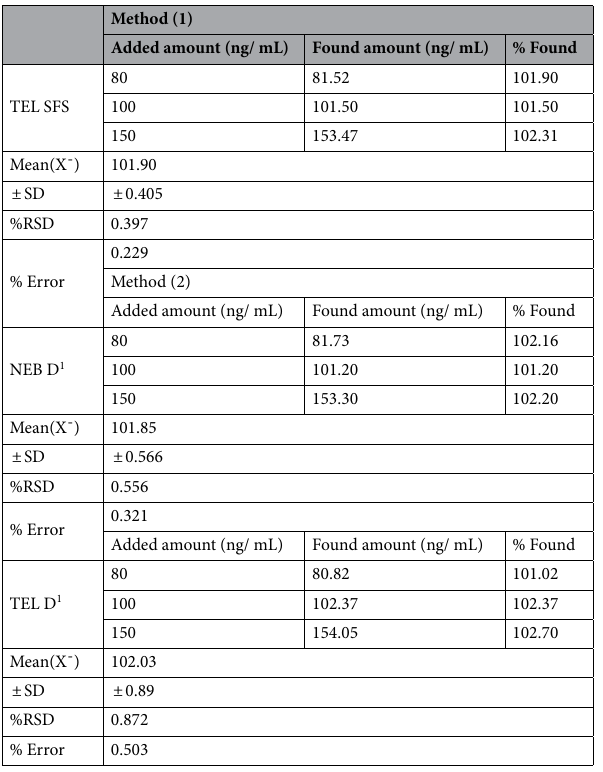
Table 6. Recovery data of TEL and NEB from spiked human plasma by the proposed synchronous fluorescence spectroscopy method (for TEL) and first derivative synchronous fluorescence spectroscopy method (for NEB and